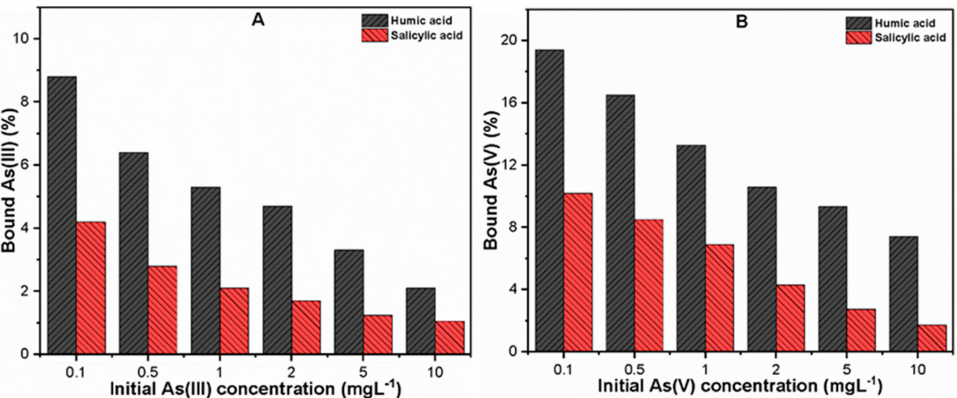
Figure 1. Percentages of bound ( A ) As(III) and ( B ) As(V) in 10 mgL − 1 of humic / salicylic acid solutions under neutral pH (7 ± 0.1) at 25 ± 1 ◦